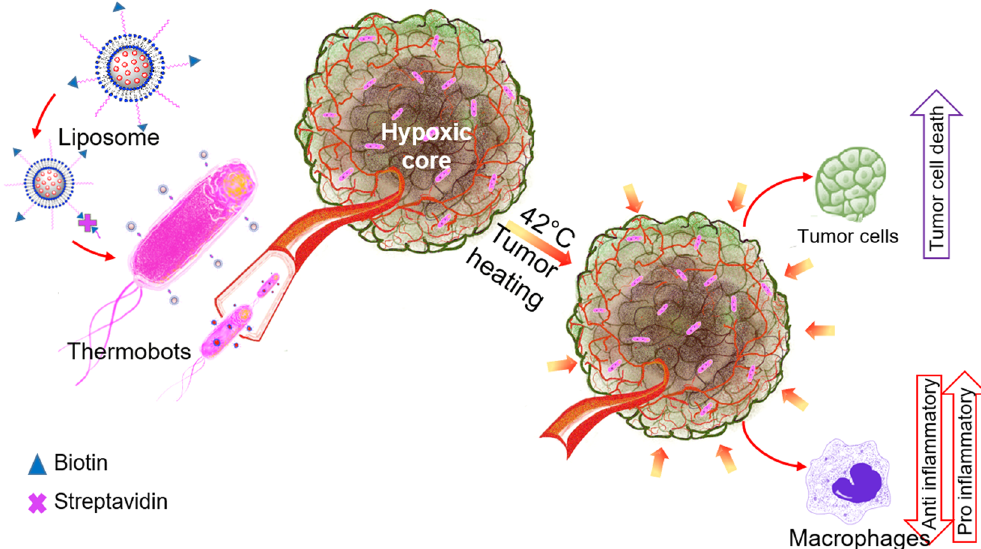
Figure 1. Schematic of thermobot and heat-combined chemo-immunotherapy approach against colon